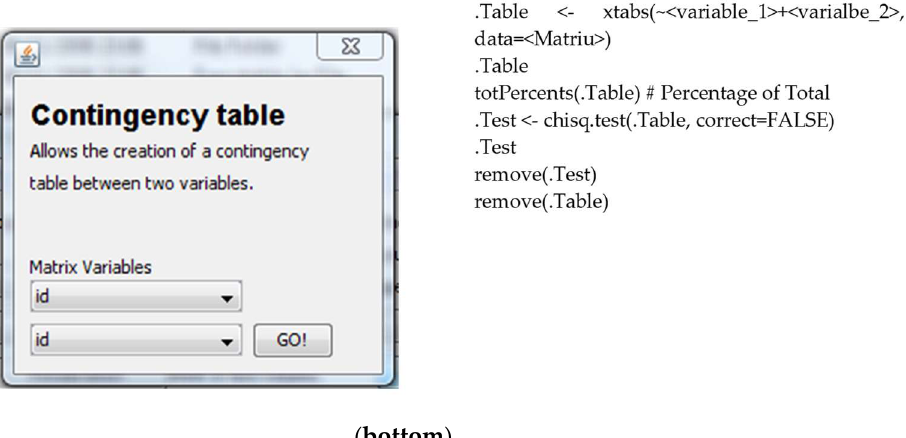
Figure 8. JGUIforR selection and contingency table operations and its R code. The R code to select the rows in a matrix that have the value of “BARCELONA” in the variable Provincia (province) is shown ( top ). In the bottom , the GUI used for the contingency table operation is shown (see Section 4.3.3). Next, you can see the output for the contingency table in R code. The output obtained is a double entrance table, with total percentages and a chi-square test to analyze the independency. The output is reformatted and uses only two decimals to simplify the reading.